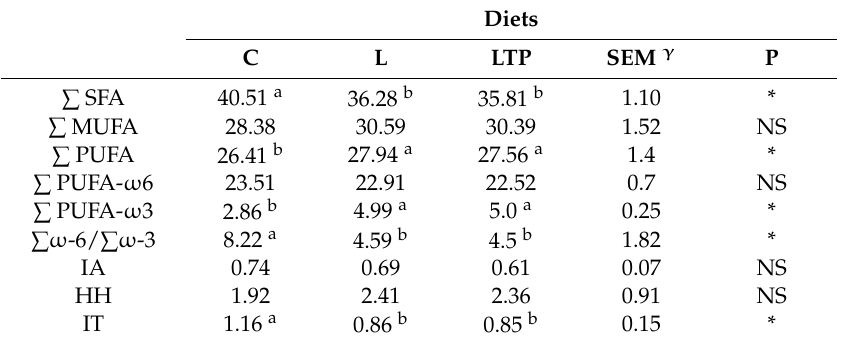
Table 3. Sum and ratios of fatty acids (%) and health lipid indexes of lyophilized eggs’ yolks $